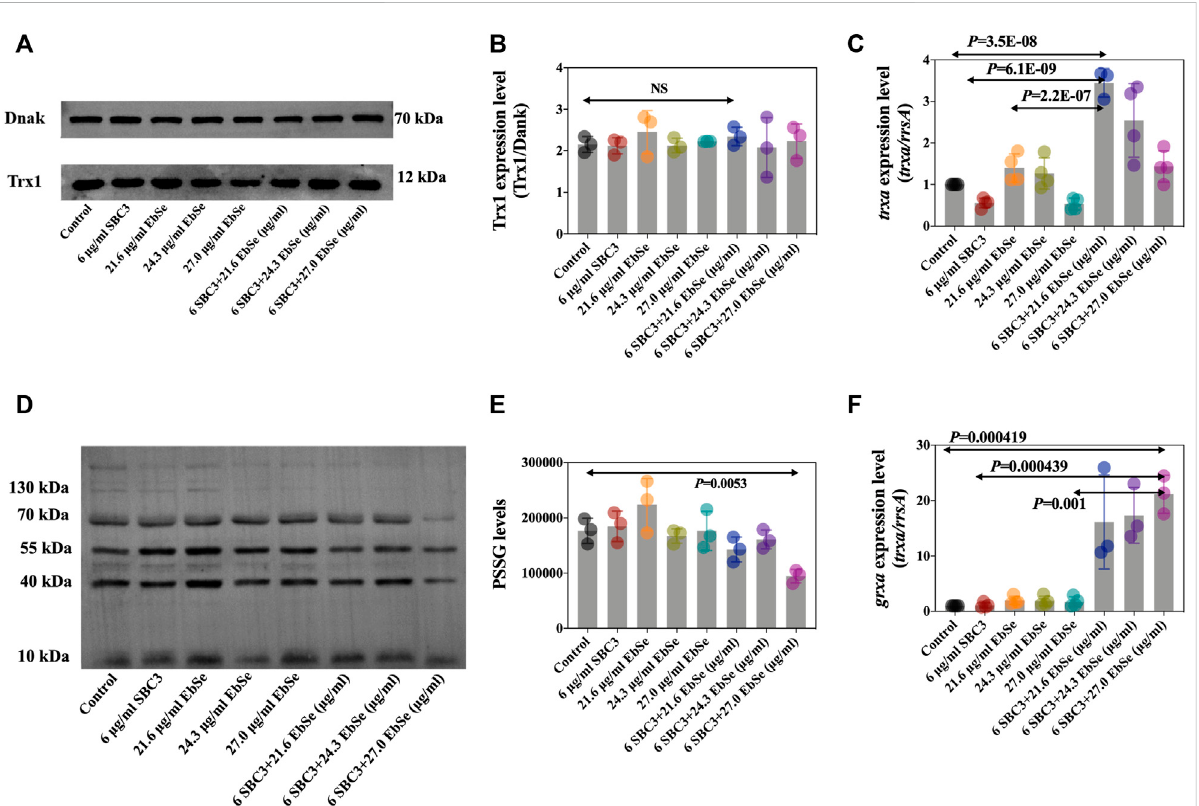
FIGURE 4 SBC3withEbselenincombinationdirectlydisruptedbacterialTDRSsystems.DHB4wascultureduntilanA 600 =0.4andtreatedfor30 minwith serialconcentrationsofSBC3andEbselen. (A,B) Trx1proteinlevelwasmeasuredbyWesternblot. (C) trxa (Trx1)mRNAexpressionlevelwastestedby qPCR. (D,E) S -PSSG protein level was measured by Western blot. (F) grxa (Grx1) mRNA expression level was tested by qPCR. For Western blot, DnaK was used as a reference; for qPCR, rrsA was used as a reference. Data are presented by ONE-WAY ANOVA, p < 0.05 constitutes statistical signi fi